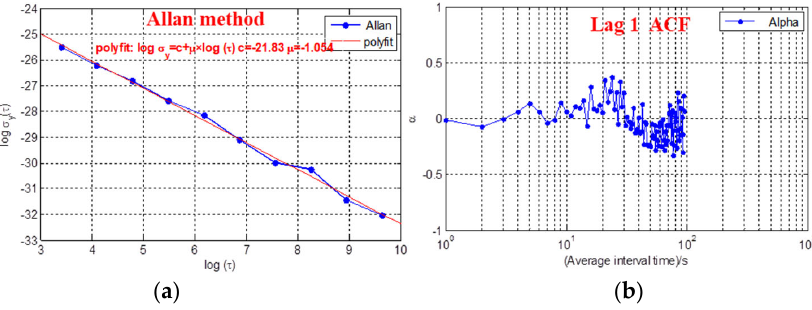
Figure 7. ( a )Power spectral density and ( b ) lag 1 method noise result of simulated frequency.